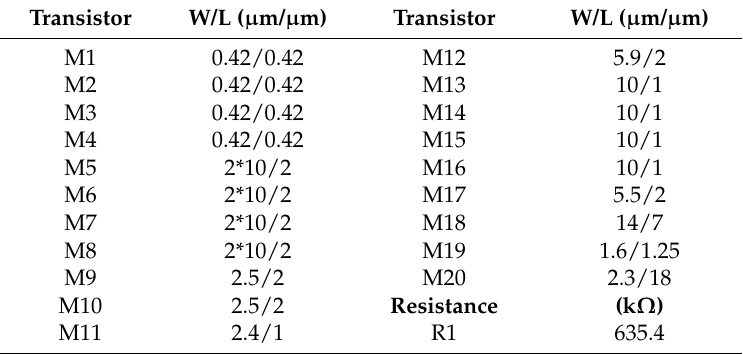
Table 1. Device size of the proposed circuit.